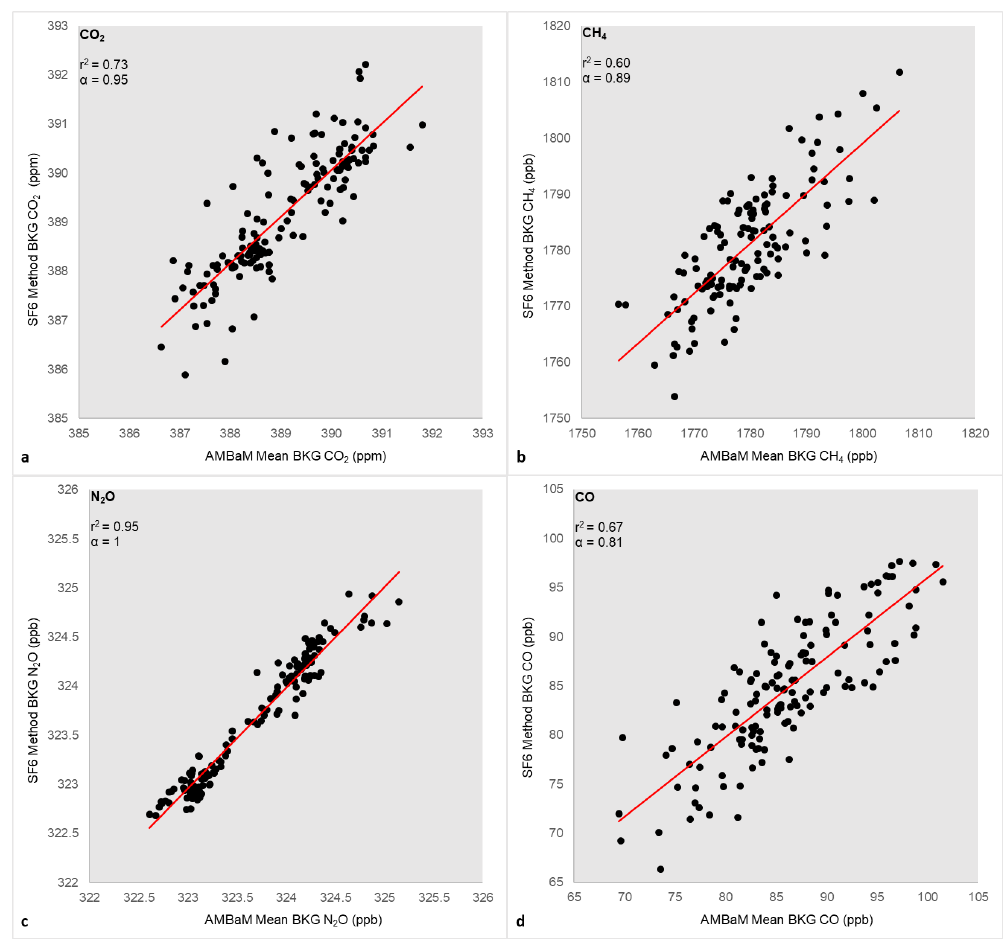
Figure 2. Correlation between BKG methods results, AMBaM and SF 6 -based, and its coefficient of determination (r 2 ) and the slope ( α ) for the studied gases. ( a ) CO 2 results. ( b ) CH 4 results. ( c ) N 2 O results. ( d ) CO